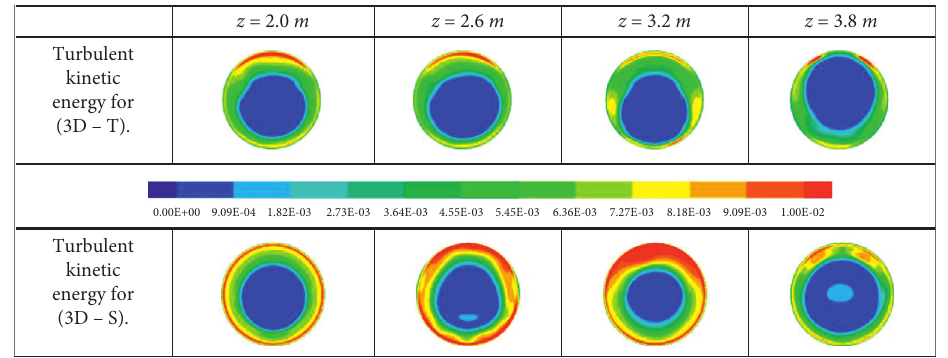
Turbulent kinetic energy for (3D – T).